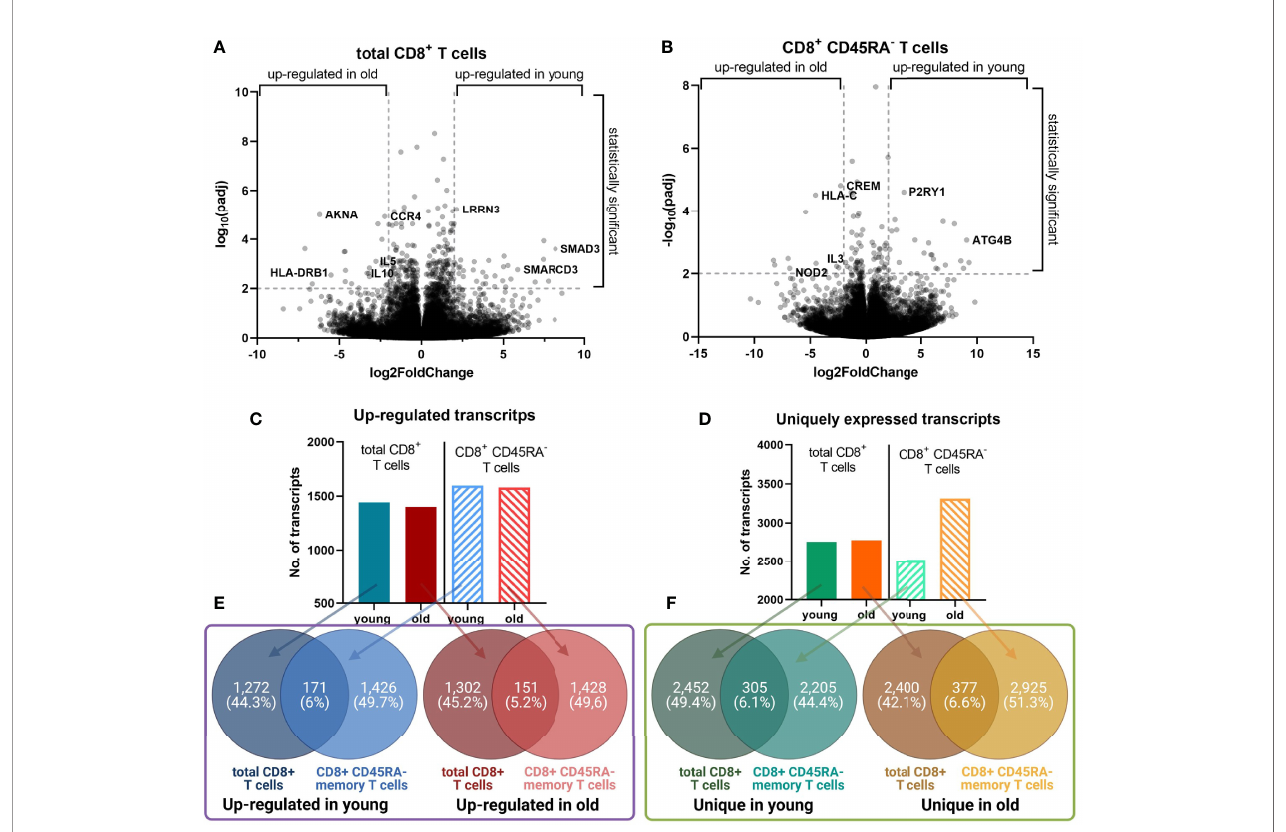
FIGURE 4 | Identi fi ed differentially expressed transcripts in young versus old donors. (A, B) . Volcano plot for the transcripts with an up-regulated gene expression in the total and memory CD8 + T cell populations, respectively. The log 2 (FoldChange) of the transcripts was plotted against the -log 10 (padj). Selected genes with the lowest adjusted p values are labeled. A line is placed at a -log 10 (padj) of 2, which corresponds to an adjusted p value of 0.01. (C, D) . The number of transcripts with an up-regulated expression, and uniquely expressed transcripts, respectively. For both CD8 + T cell populations the number of transcripts from each dataset are plotted as a graph plot. (E, F) . Overlap between the transcripts for the total and memory CD8 + T cell population. For both T cell populations, the overlap between the up-regulated and unique transcripts was calculated with Venny 2.1.0 and the fi gure was prepared with